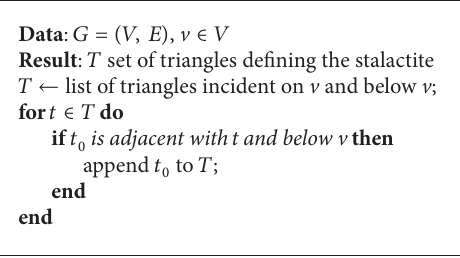
Algorithm 3: Algorithm to determine stalactites.